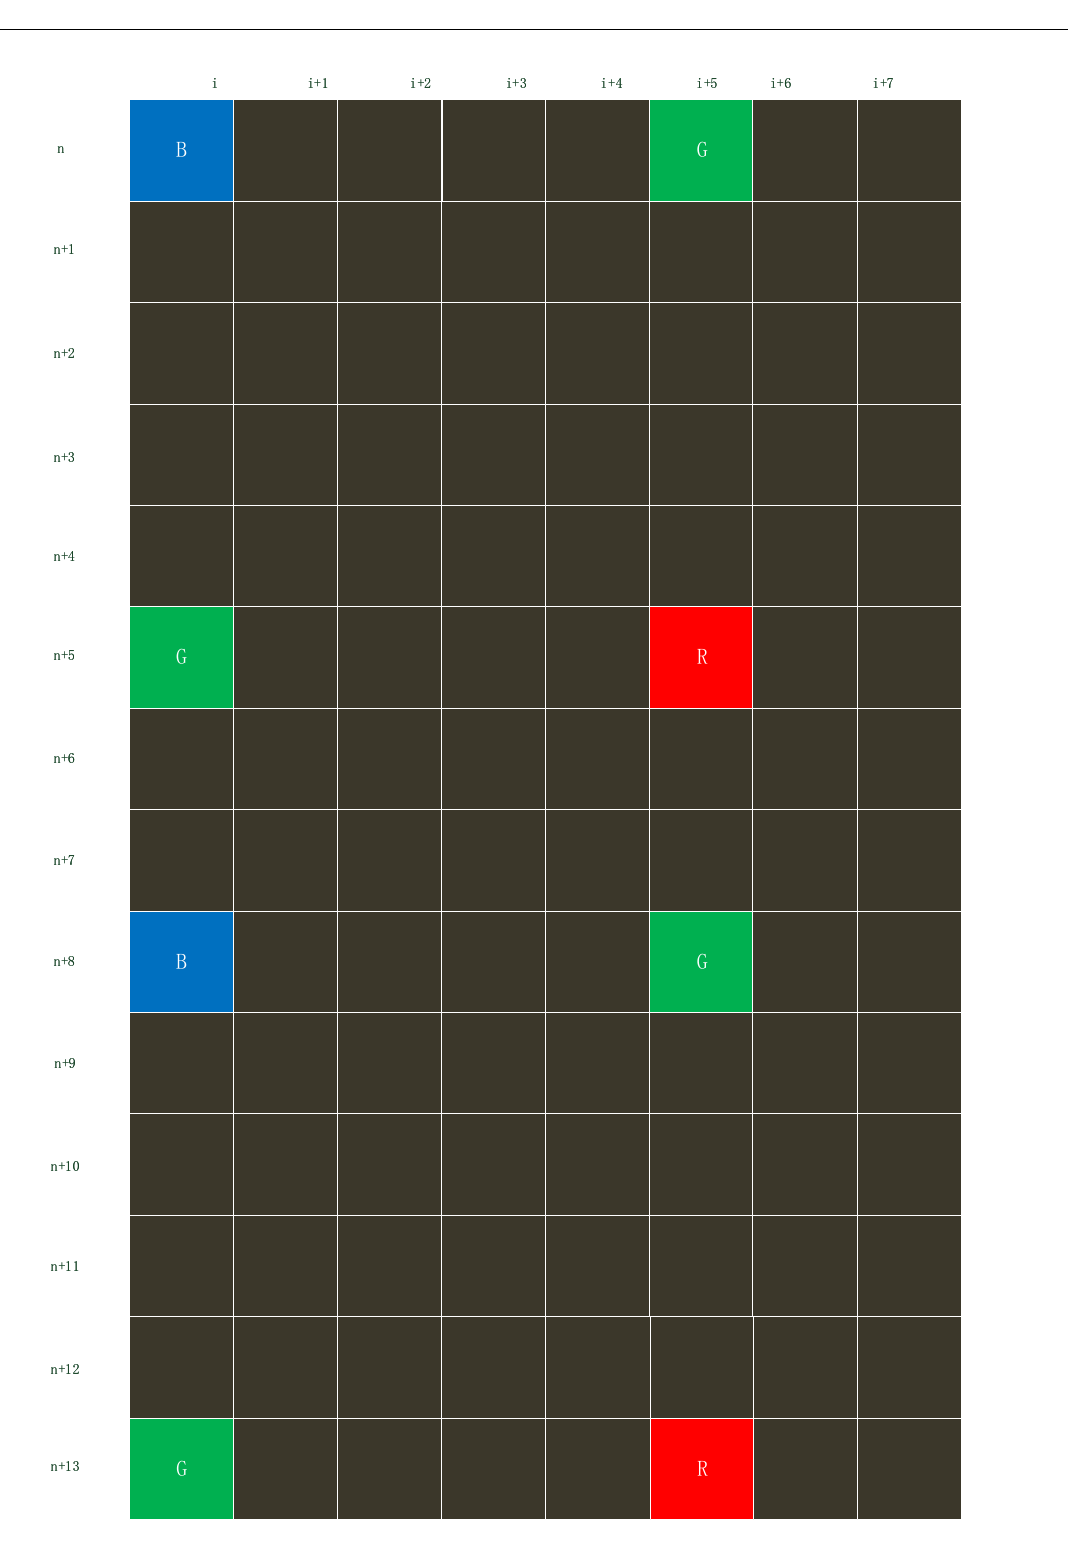
Figure 5. The schematic diagram of 4:4